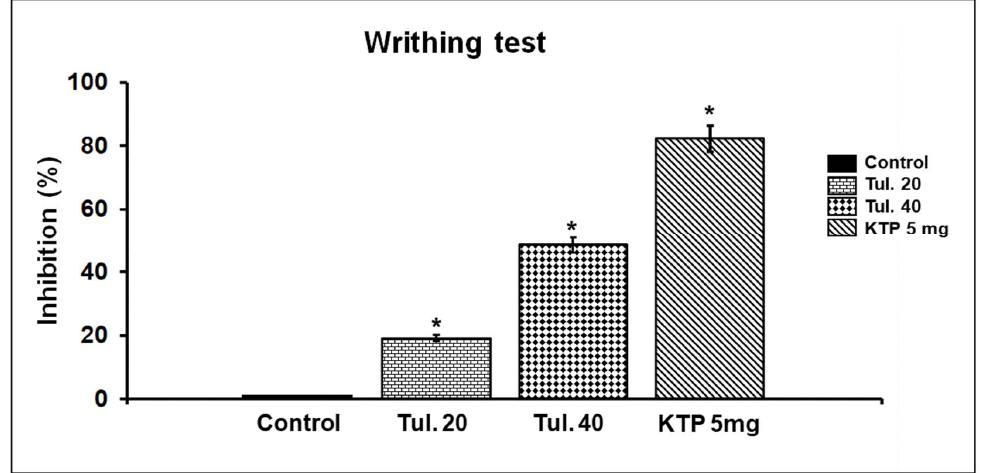
Figure 4. The percentage of inhibition induced by tulathromycin at 20 (Tul. 20) and 40 (Tul. 40) mg/kg BW s.c. and ketoprofen (KTP; 5 mg/kg BW s.c.) against the writhing reflexes triggered by acetic acid (0.1 mL/10 g BW of 0.1% solution ( v / v , i.p.)). Data are expressed in mean ± SD; n = 5. * Significantly different from control, p < 0.05. Table 4. Effects of tulathromycin (20 and 40 mg/kg, SC) and ketoprofen (5 mg/kg BW s.c.) on the nociceptive responses triggered by s.c. injection of formalin (20 ul of 2.5%, v / v ) in the dorsum of the hind right paw in mice (mean ± SD; n = 5).